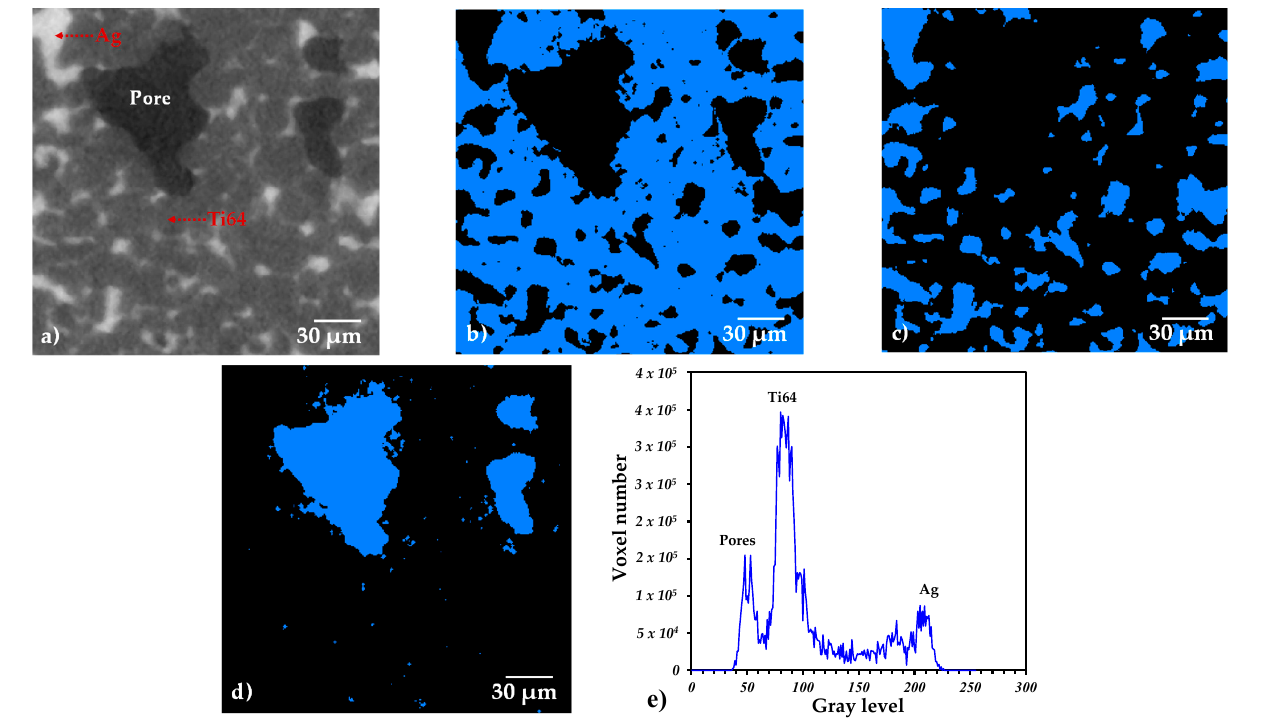
Figure 3. 2D virtual slices of the Ti64/20Ag sample with 30 vol.% of pore formers after sintering: ( a ) grey level image, ( b – d ) binary images of Ti64, Ag and pores, respectively. ( e ) Histogram of voxel gray levels of the complete 3D image.